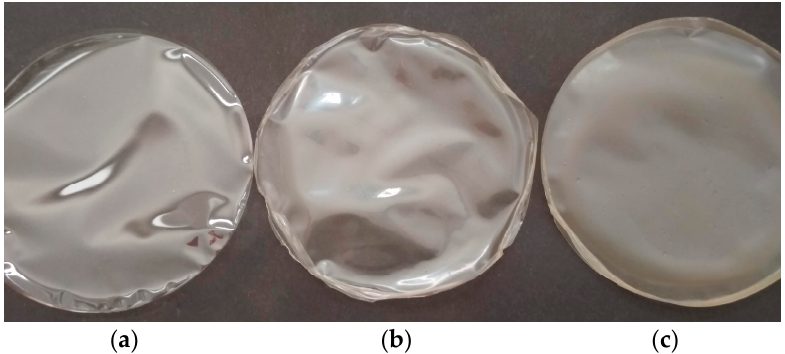
Figure 2. Appearance of chitosan films: ( a ) control; ( b ) A80-0.5; ( c ) A80-2.